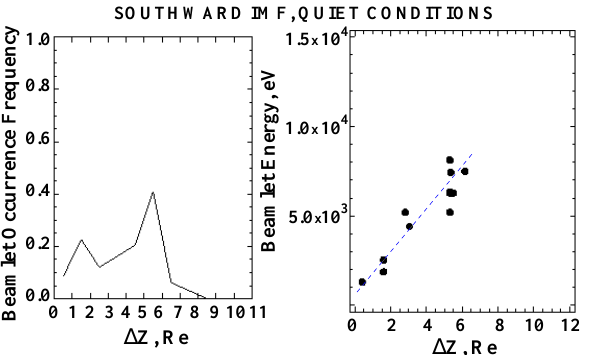
Fig. 6. Left panel: beamlet occurrence frequency versus the nomi- nal distance from the neutral sheet ( 1Z ) for quiet magnetospheric conditions under the southward IMF. Right panel: scatterplot of beamlets energy (i.e. energy associated with the field-aligned ve- locity of the beam) versus 1Z